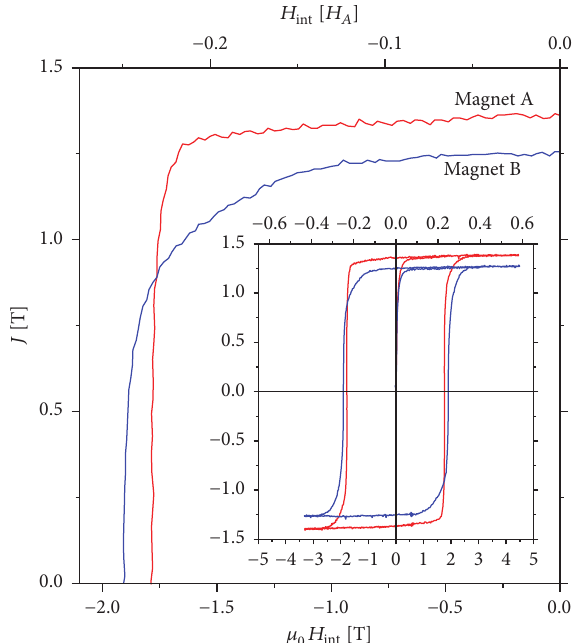
Figure 1: Hysteresis curves of magnets A and B measured with a HIRST pulsed field